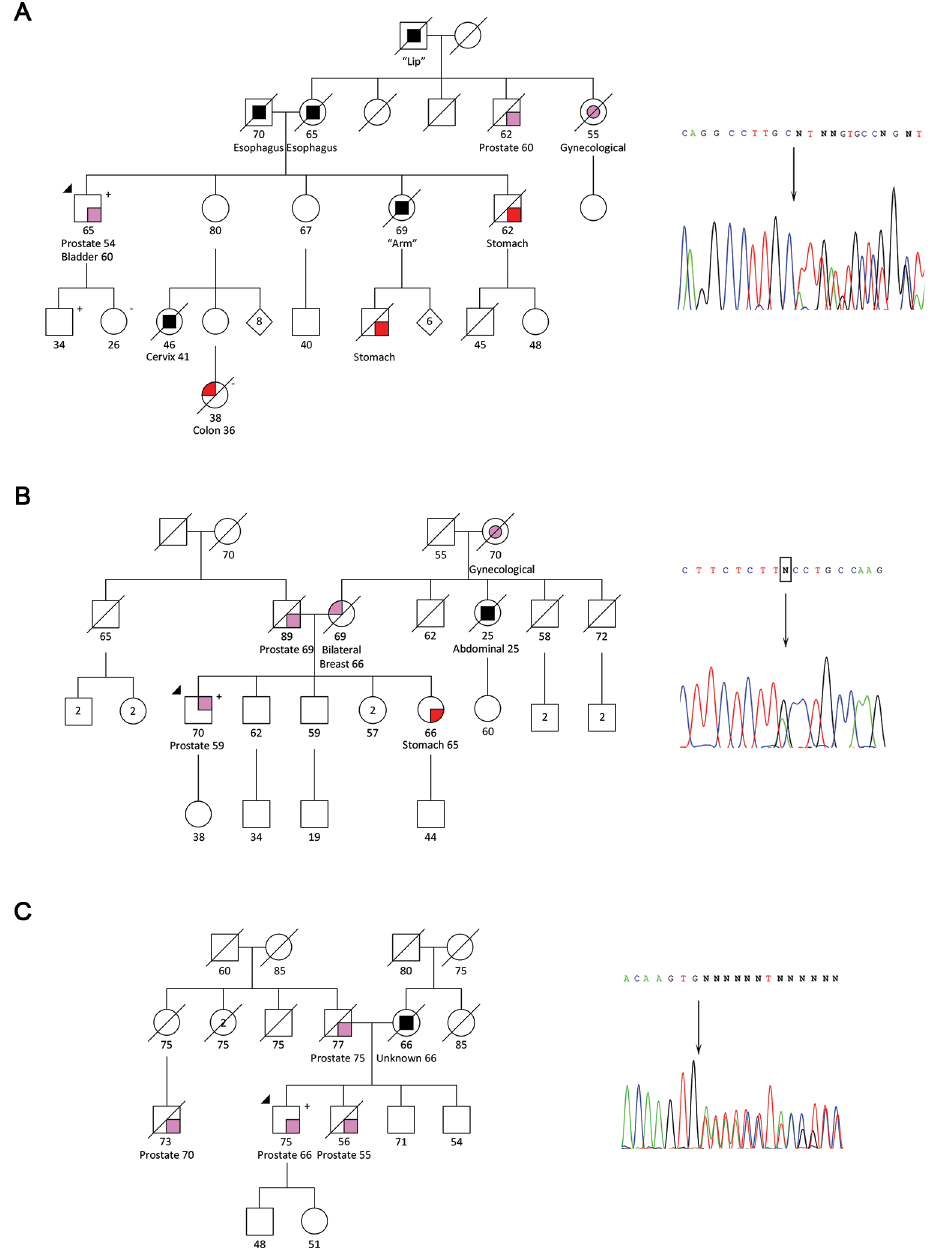
Fig 2. Pedigrees of patients carrying truncating/deleterious mutations in new candidate PrCa risk genes involved in Fanconi anemia. (A) Patient HPC186 harboring the RAD51C frameshift mutation c.890_899del. (B) Patient HPC447 harboring the FANCD2 splicing mutation c.2494+2T > C. (C) Patient HPC150 harboring the FANCI frameshift mutation c.206del. Electropherograms of the Sanger sequencing validations are shown.